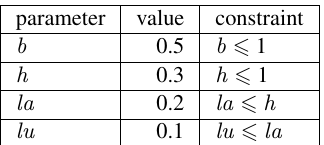
Table 1. Reward function parameters, default values and